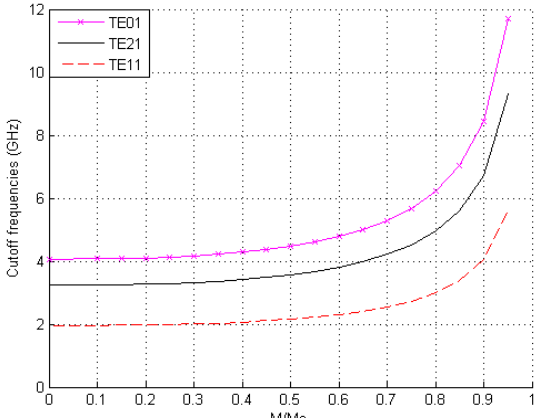
Figure 5. The cutoff frequencies for the first three TE modes vs. M